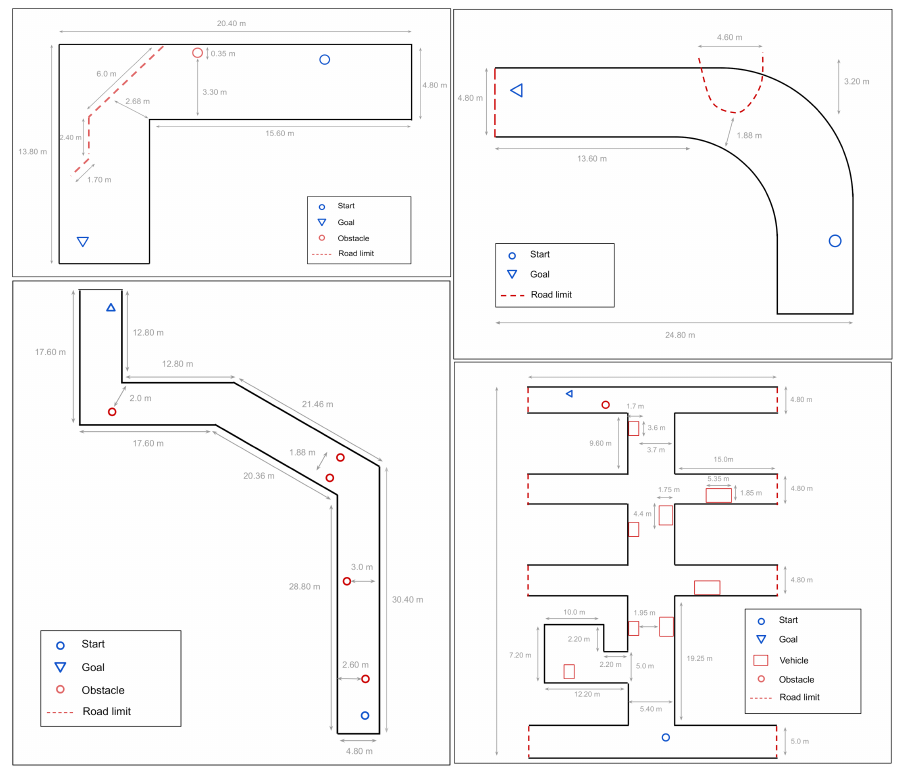
Figure 7. Real-scale simulated environments maps for self-driving